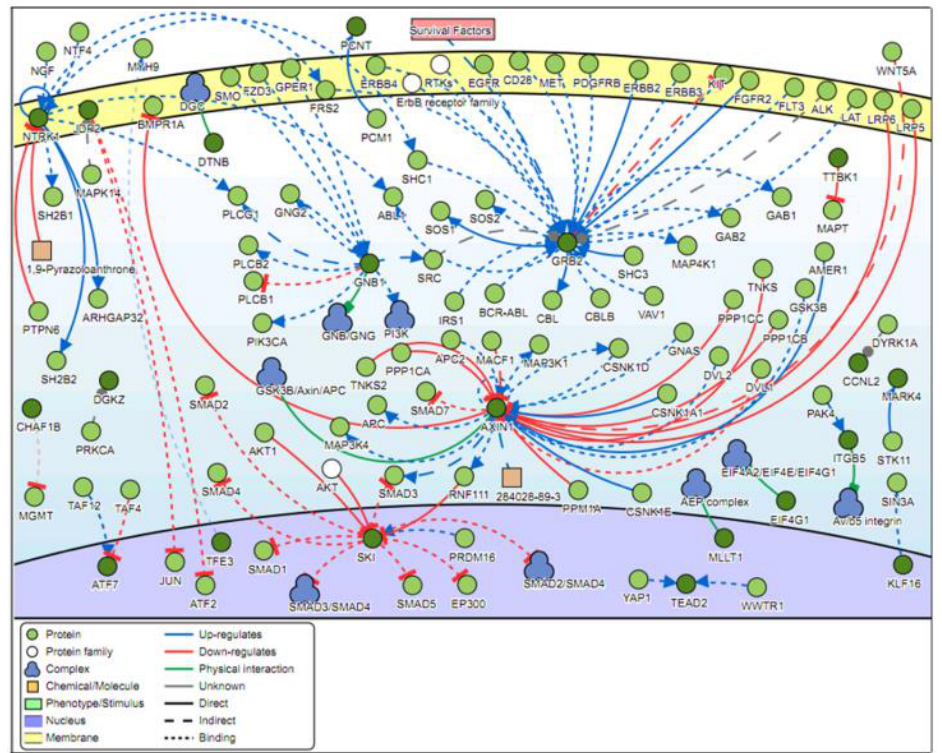
Figure 4. Scatterplot ( A ) and volcano plot ( B ) analysis for the top 1000 most differentially methylated CpG islands. In ( A ), the mean of mean methylation levels (beta value) for normal skin across all sites in a region (mean.mean.beta.NS) is on the x axis, and the mean of mean methylation levels (beta value) for warts across all sites in a region (mean.mean.beta.W) is on the y axis. Methylation beta values ranged from 0 (unmethylated) to 1 (fully methylated). In ( B ), the figure illustrates the overall extent of hypermethylation (>0) and hypomethylation (<0) of the top 1000 most differentially methylated CpG islands. Differential methylation was quantified by log 2 of the mean quotient in means across all sites in a region (mean.mean.quot.log 2 ) and the mean difference in means across all sites in a region (mean.mean.diff) between W and NS.